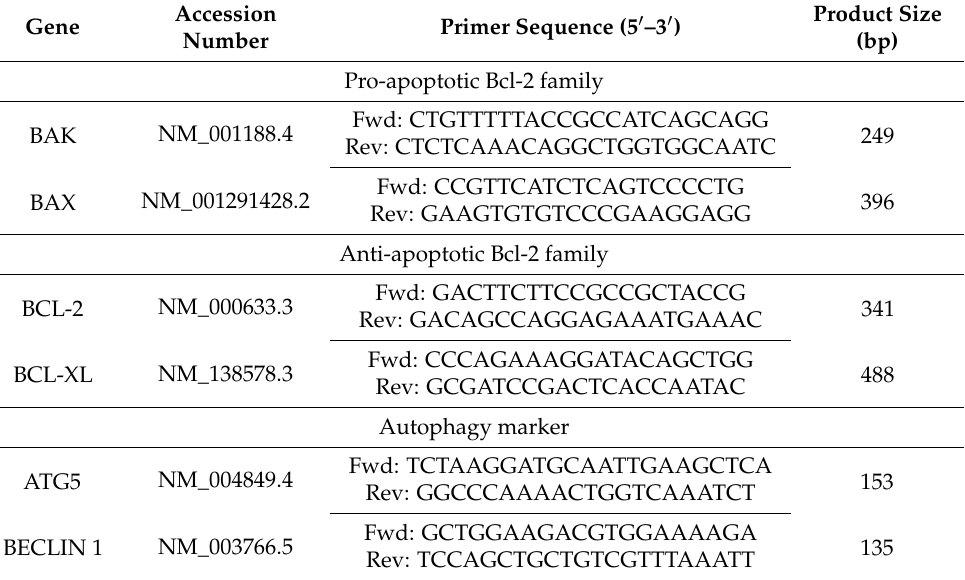
Table 1. Primer design for apoptotic Bcl-2 family and autophagy